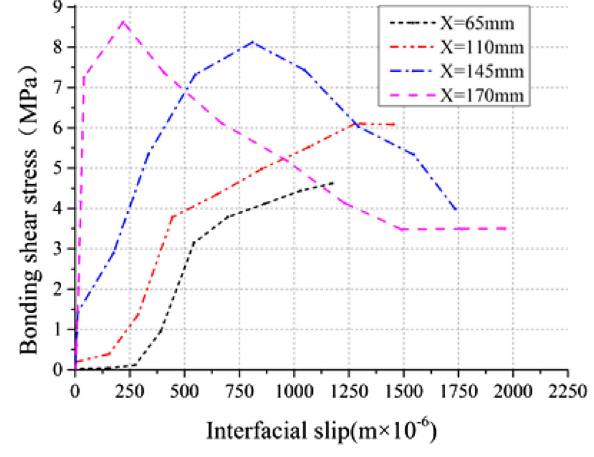
Fig. 8 Strain distribution of CFRP strip (T40)